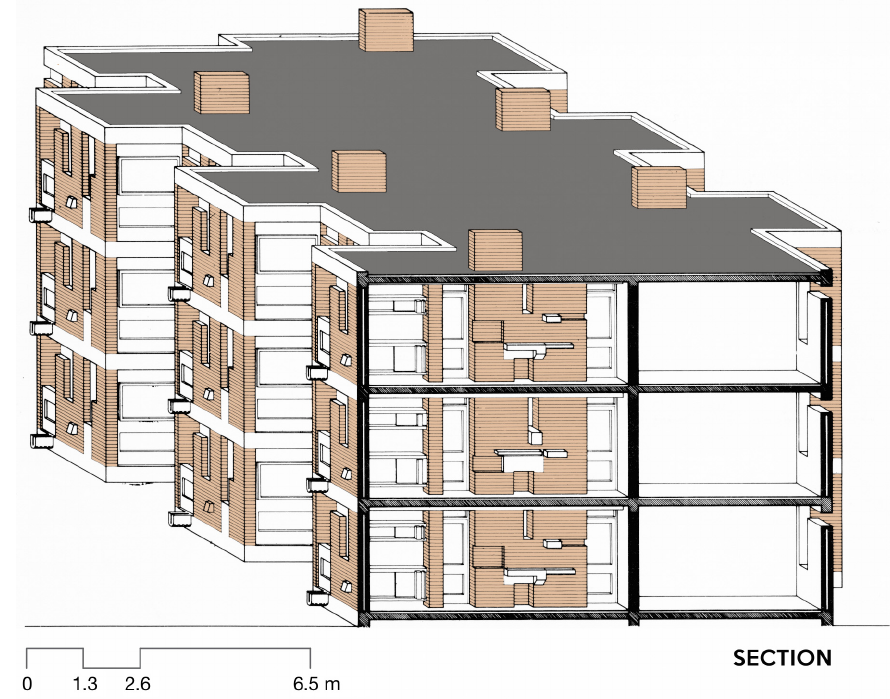
Figure 7. Section of the building.